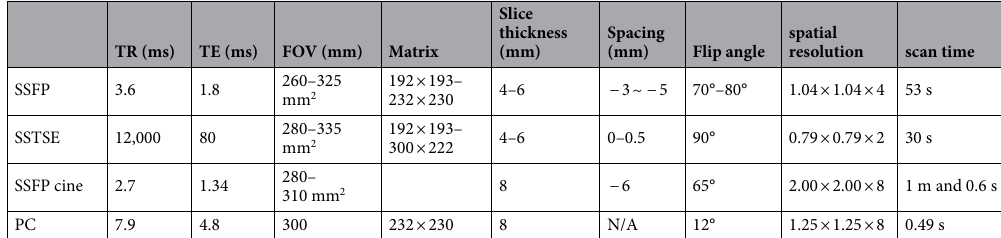
Table 2. All scanning parameters of fetal CMR sequences. SSFP steady-state free-precession, SSTSE single- shot turbo spin echo, PC phase contrast, TR repetition time, TE echo time, FOV field of